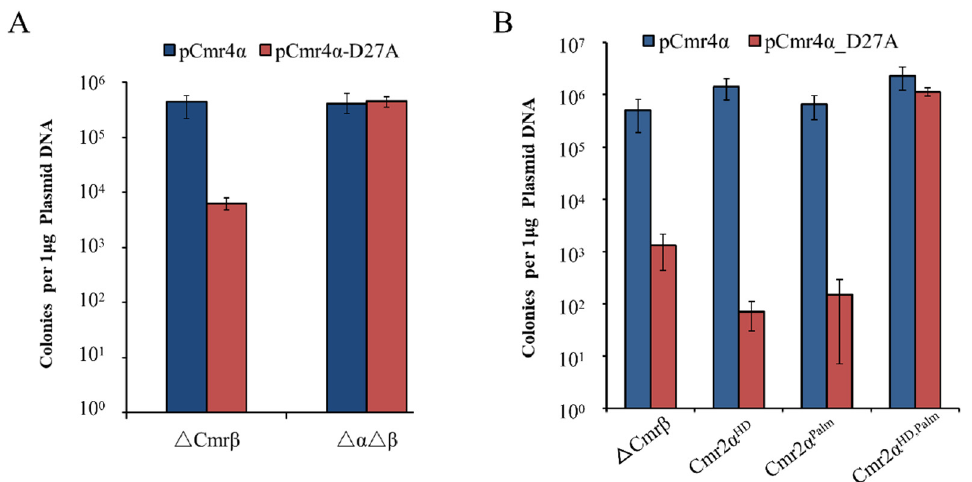
Figure 1. The dCmr4 α -induced cell death is dependent on the activities of Cmr2 α . ( A ) Deletion of the cmr- α module abolished the Cmr4 α -D27A toxicity. pCmr4 α and pCmr4 α -D27A were transformed into ∆β E233S1 and ∆ α ∆ β E233S1, respectively, and the transformation efficiency was calculated. ( B ) Cmr4 α -D27A toxicity in ∆β E233 and the cmr2 α mutant strains. pCmr4 α and pCmr4 α -D27A were transformed into Δβ E233(WT) and the cmr2 α mutants, respectively, and the transformation efficiency was calculated.